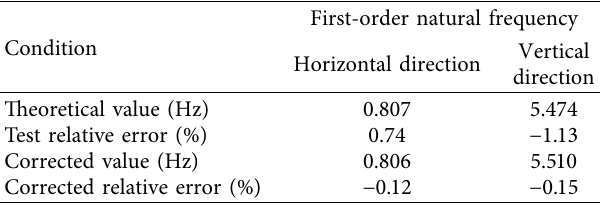
Table 8: Modal test results and corrected natural frequency of the